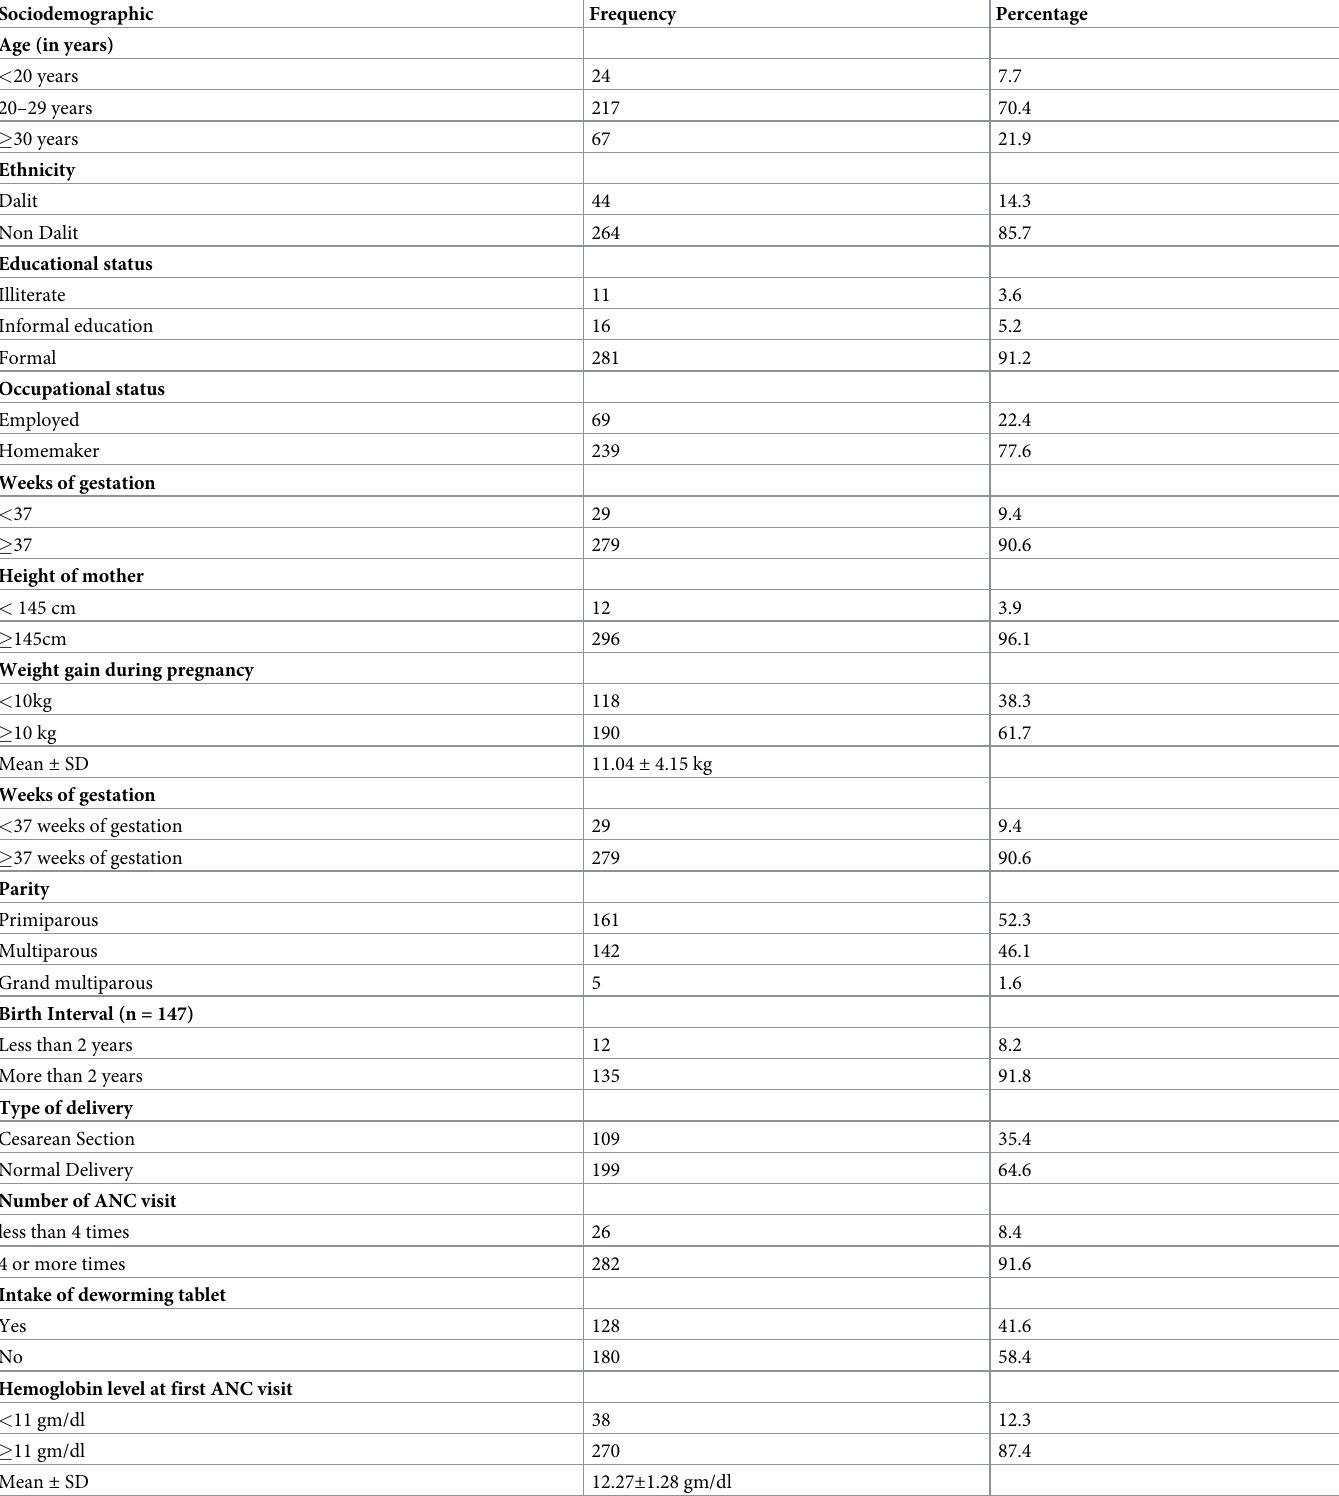
Table 1. Distribution of participants by sociodemographic factors, maternal health service and birth weight-related